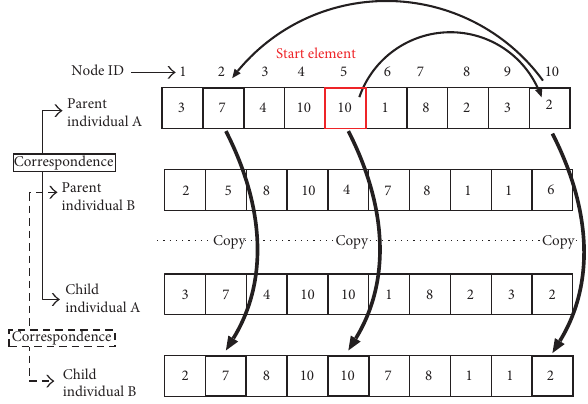
Figure 4: Example of node linkage crossover (NLX) when 𝑁 𝐶 = 1